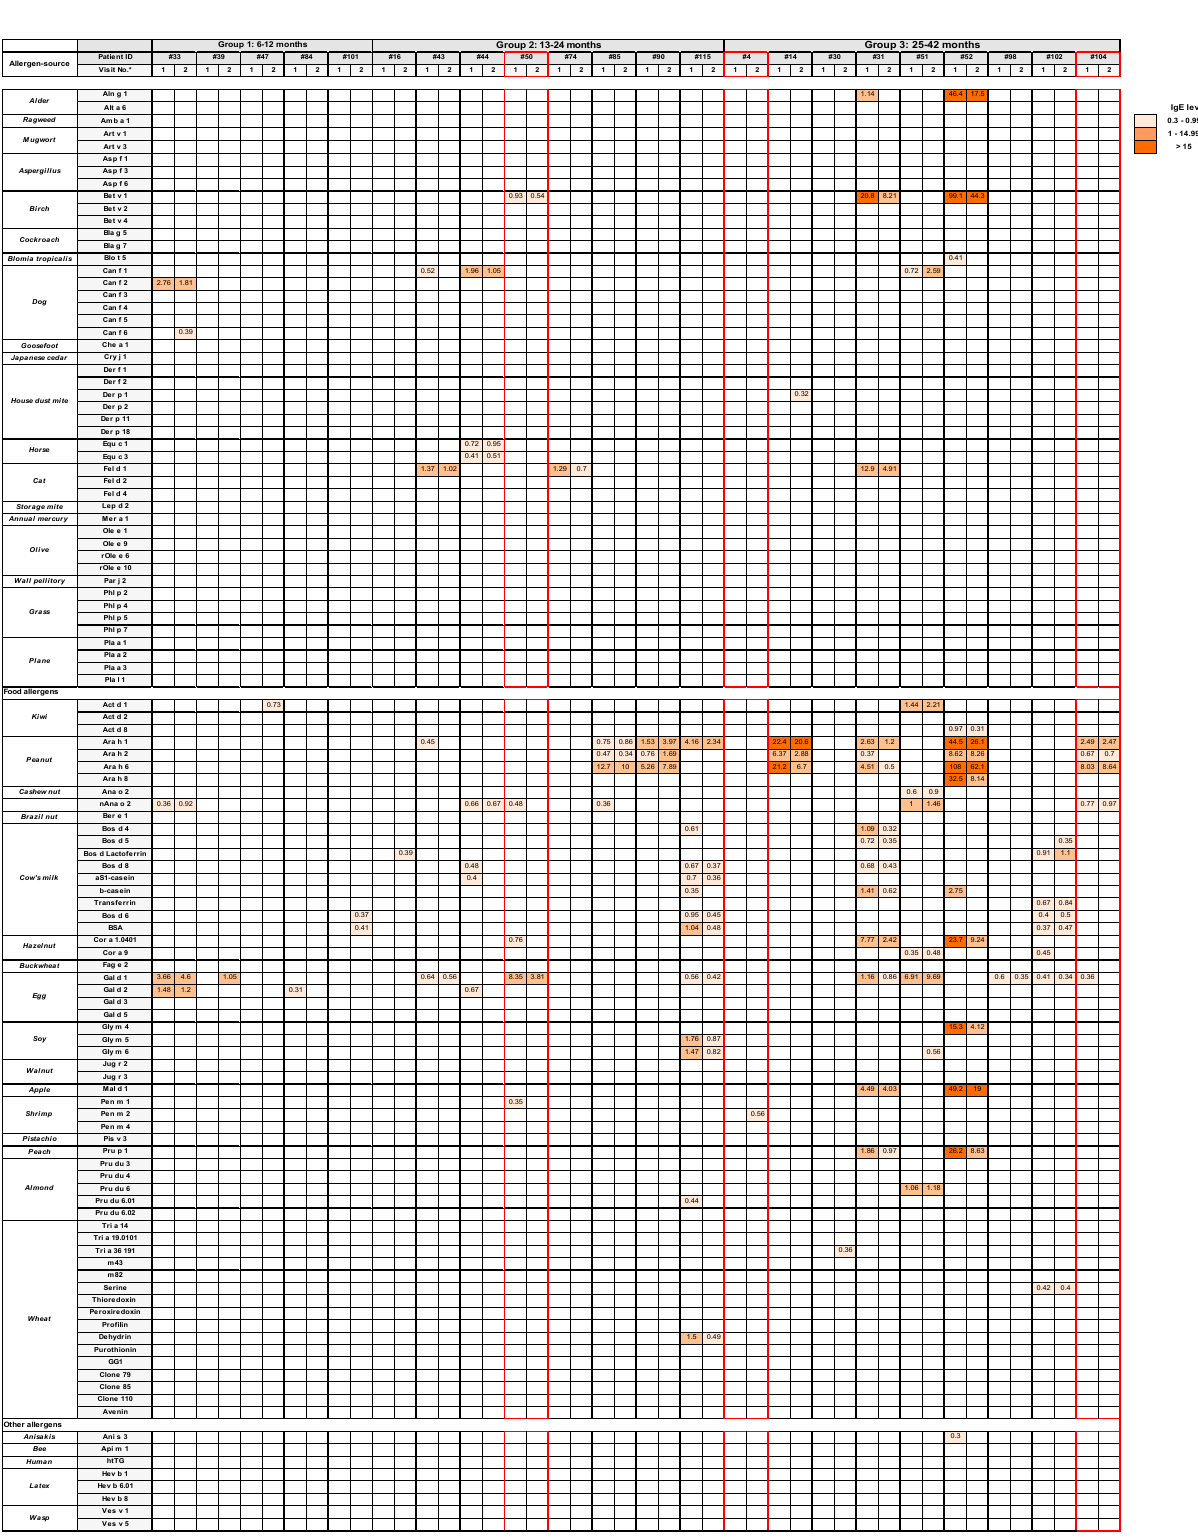
Figure 3. IgE levels to each of the individual allergen molecules on the MeDALL microarray. Specific IgE levels (in ISU-E) are displayed for each allergen molecule (left margin) at the acute (1) and follow-up visits (2) (white: no IgE sensitization, IgE < 0.3 ISU-E; light orange: = or >0.3–1 ISU-E; medium orange >1–15 ISU-E; dark orange >15 ISU-E for IgE-sensitized children from the three age groups, as indicated on top. Children without increases in RV-specific IgG antibodies are outlined in red.